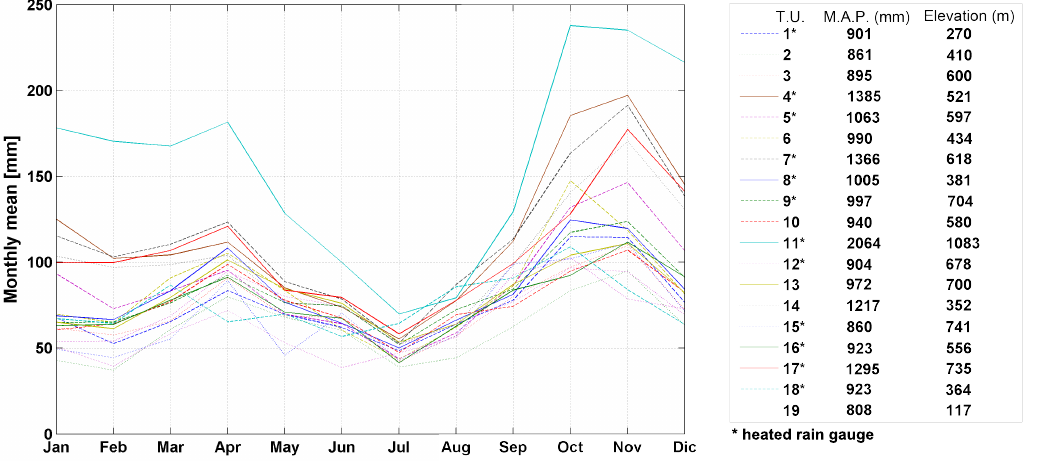
Fig. 2. Pluviometric regime of the 19 territorial units of the Emilia Romagna